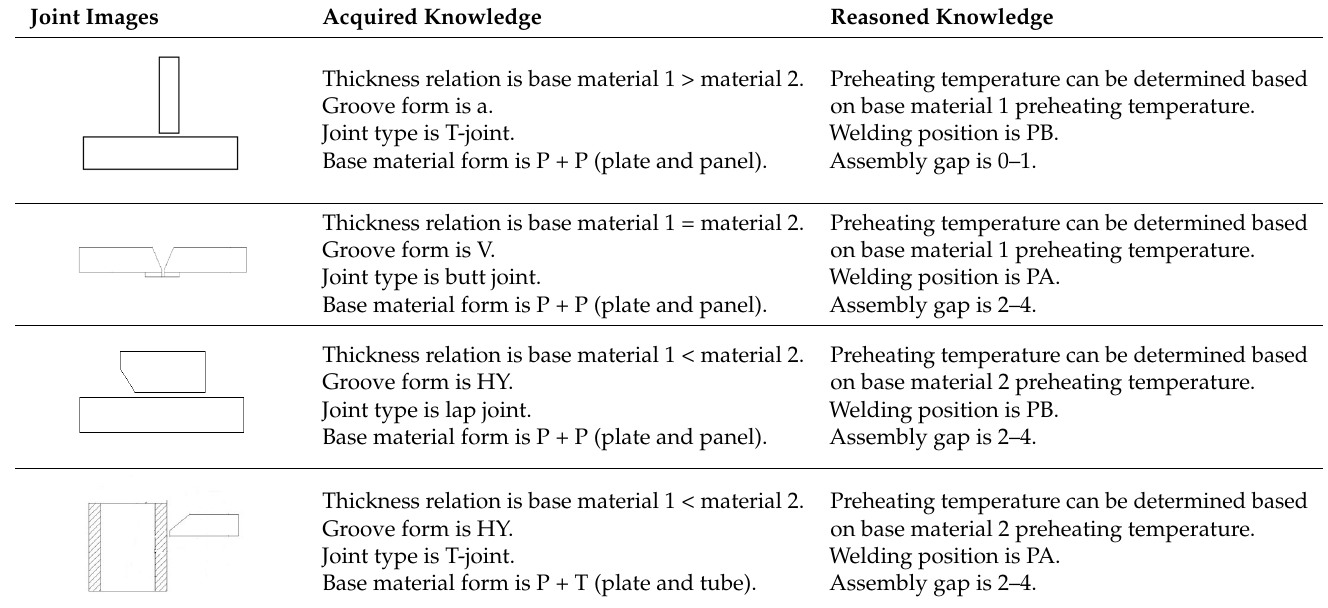
Table 5. Results for joint image knowledge